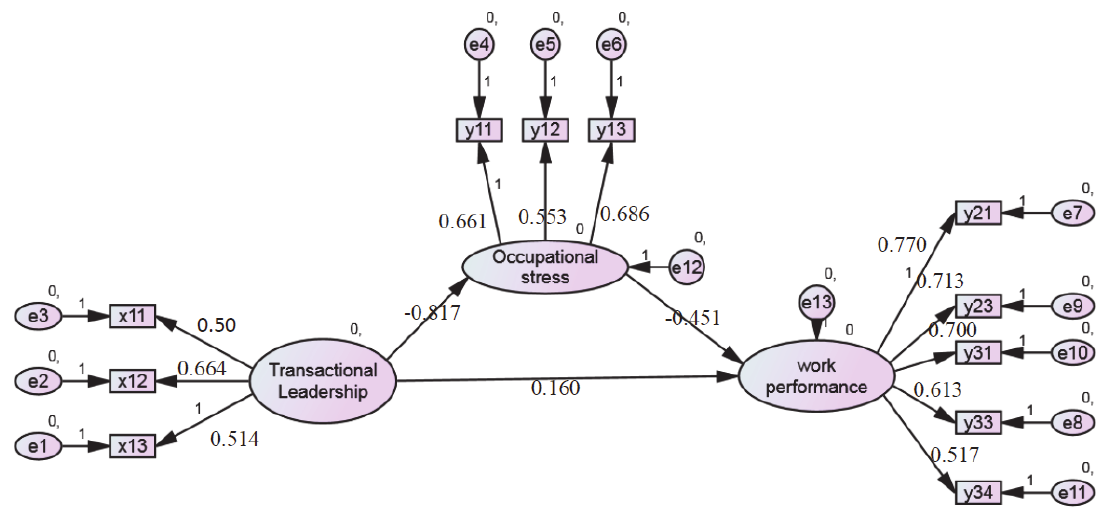
Fig. 4. Structural Model Graphic in the Last Stage of